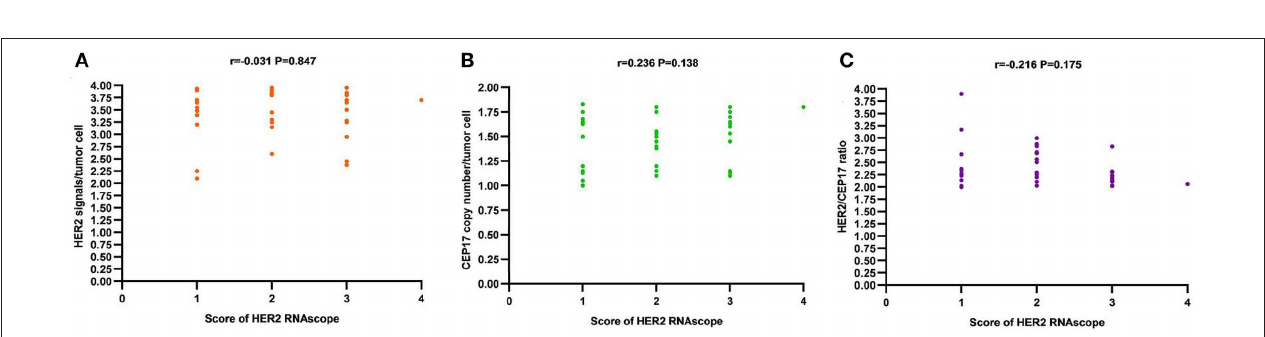
the highest average CEP17 copy numbers per tumor cell